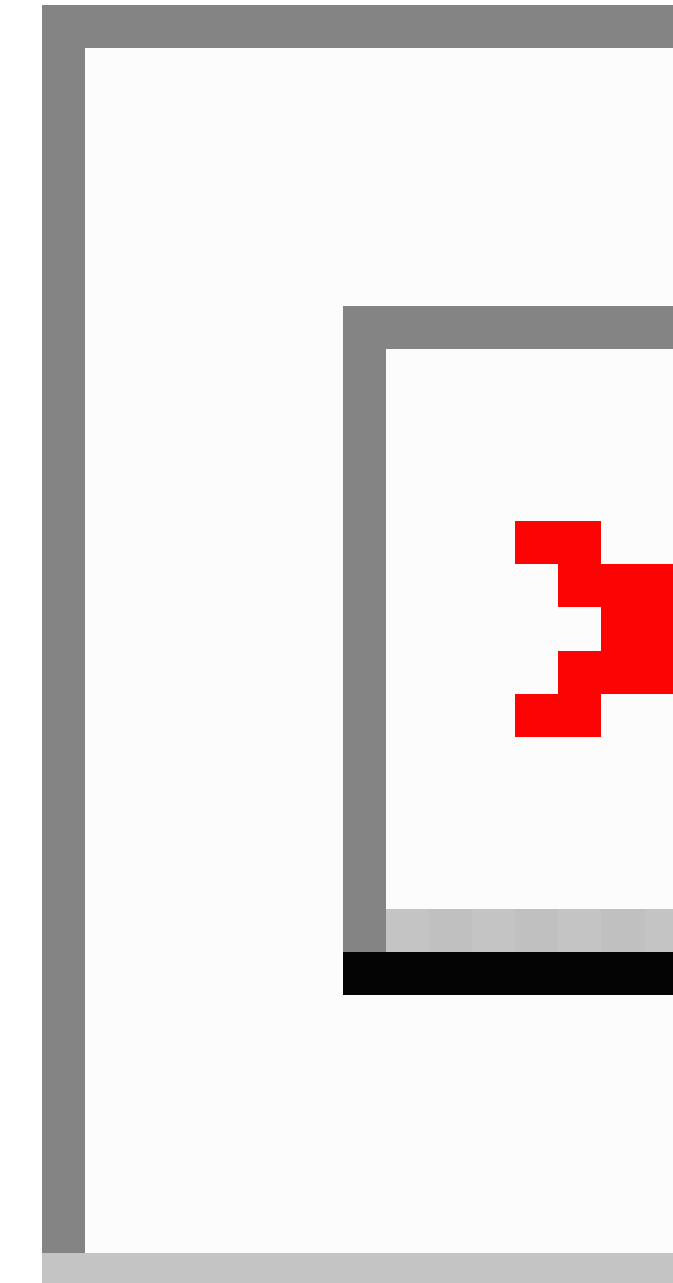
Figure 1. Consolidated Standards of Reporting Trials flow